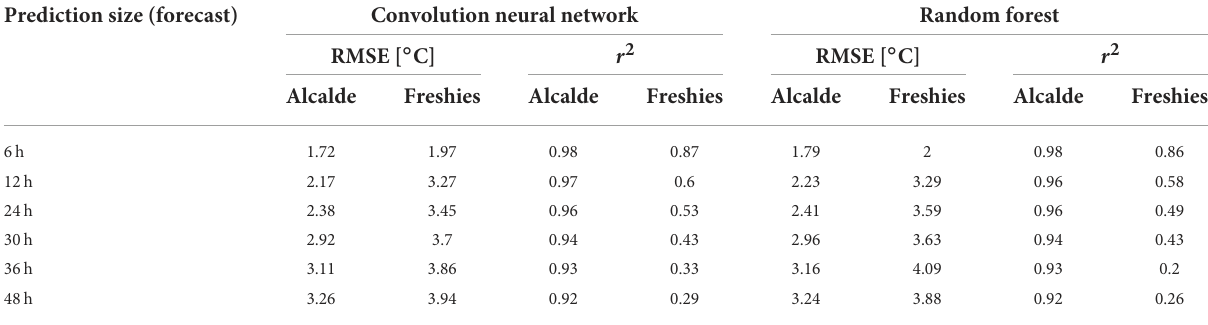
TABLE 5 Testing set statistic for both RF and CNN models using only the temperature data from the Alcalde station along with the results from the same model with additional training on the temperature data from Freshies Farm. Prediction size